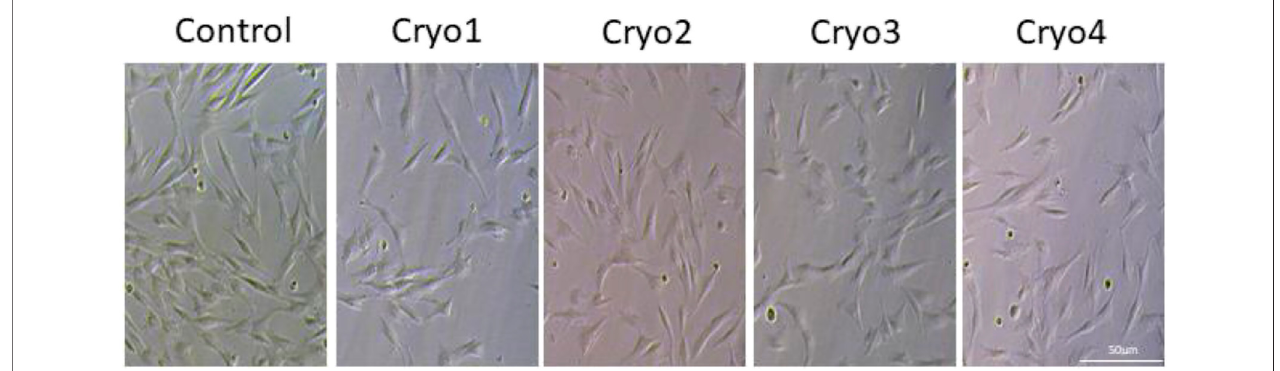
FIGURE 2 | Morphology of cultured MSCs without freezing (Control) and after cryopreservation with four cryoprotectants. The cells were grown attached to the bottom of the fl asks and exhibited typical morphology of mesenchymal cells.